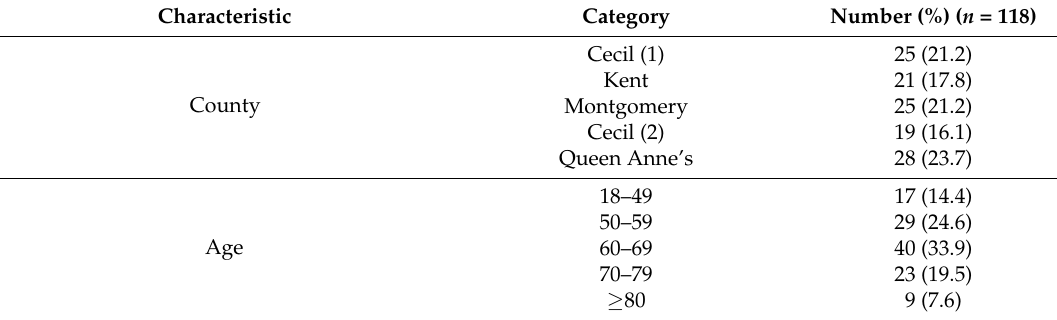
Table 2. Characteristics of the safe drinking water clinic